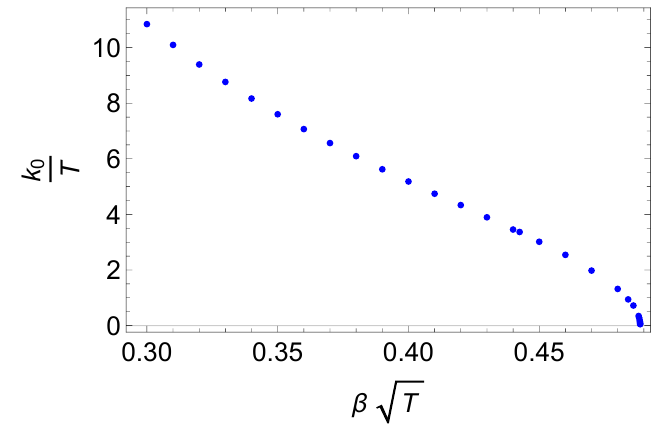
Figure 9 . The Gregory-Laflamme momentum k 0 as a function of ˆ β . The diffusion constant changes sign precisely when k 0